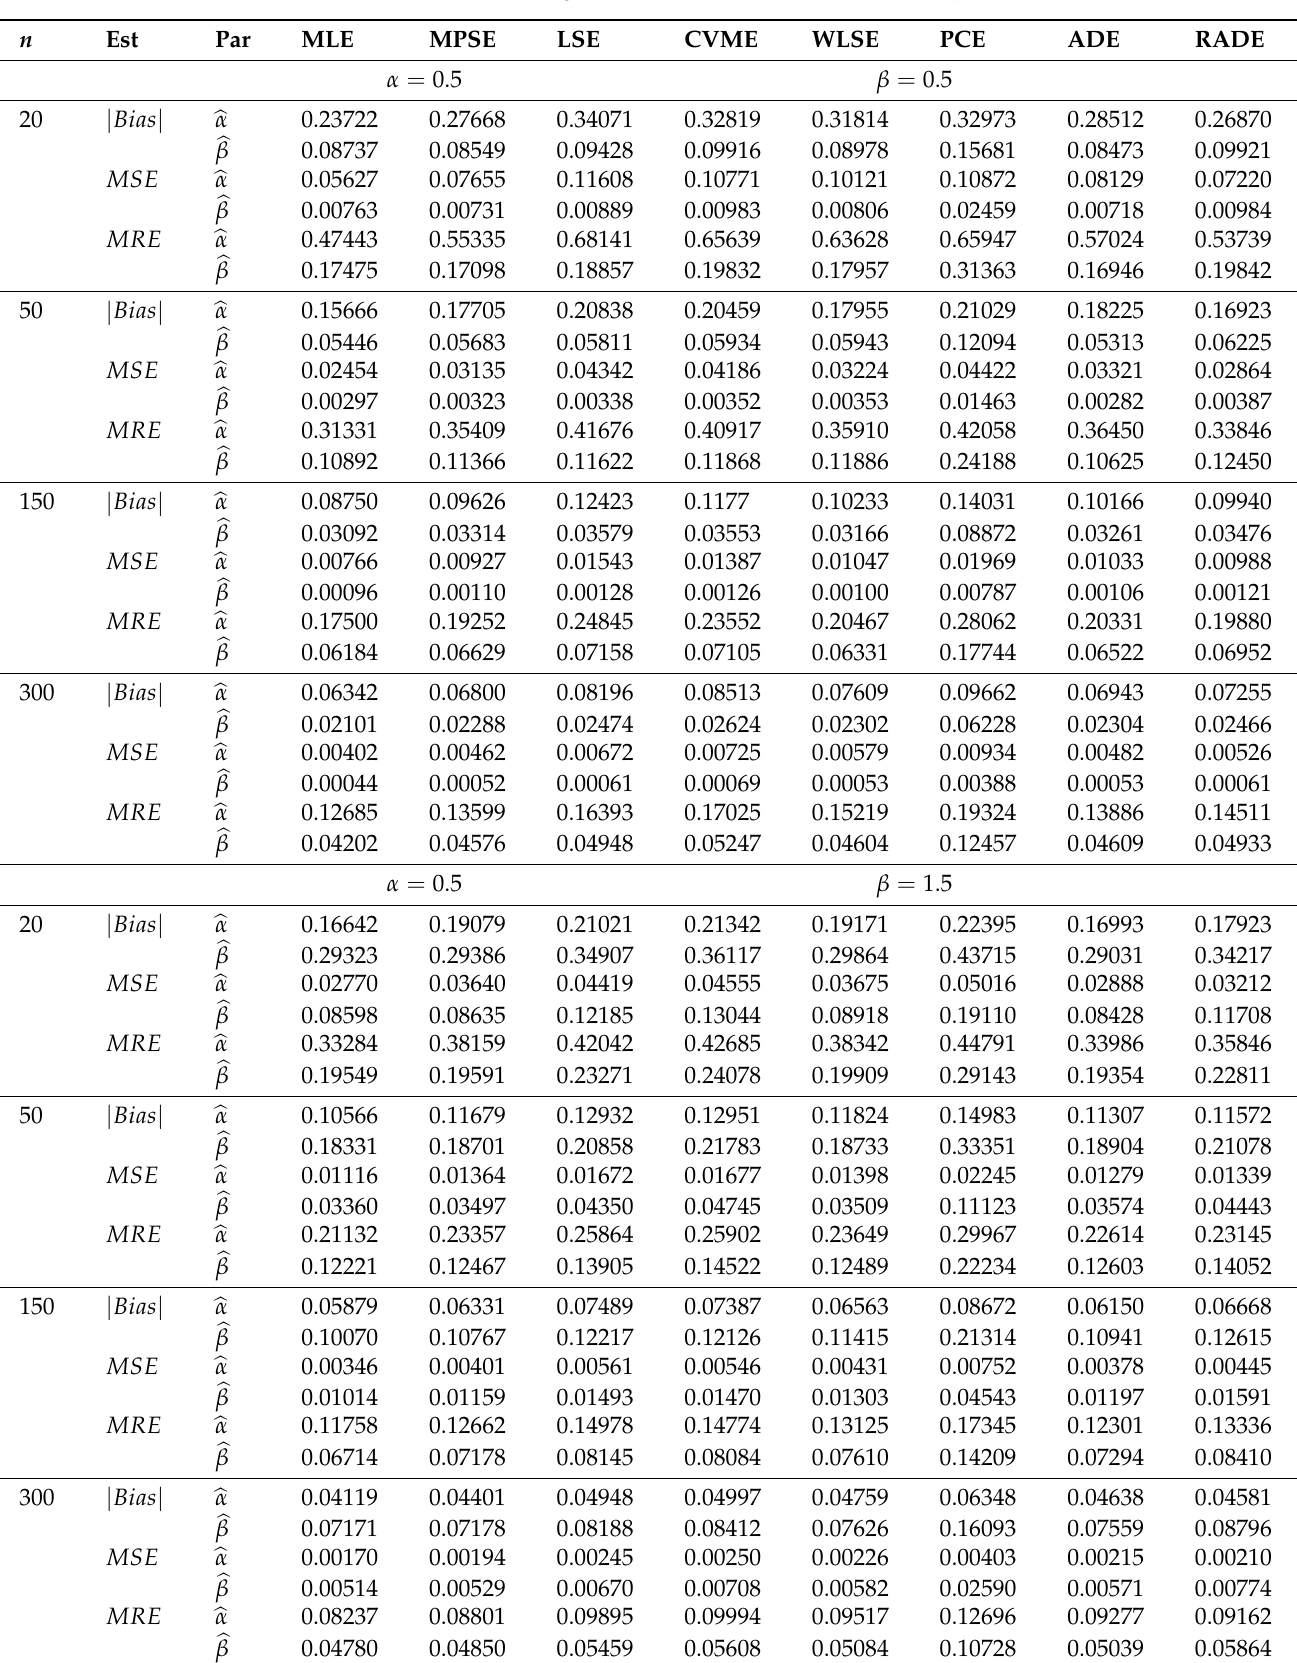
Table 3. Simulation results of the eight estimation methods for α = 0.5 and β =